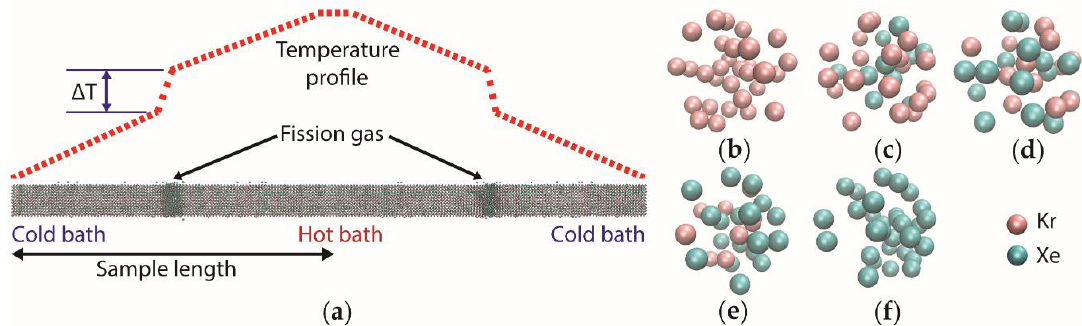
Figure 3. ( a ) The schematic of a simulation structure with fission gas bubbles. ∆T indicates the temperature jump across the fission gas bubble. ( b ) Fission gas unit with 30 Kr, ( c ) 20 Kr/10 Xe, ( d ) 15 Kr/15 Xe, ( e ) 10 Kr/20 Xe, and ( f ) 30 Xe.